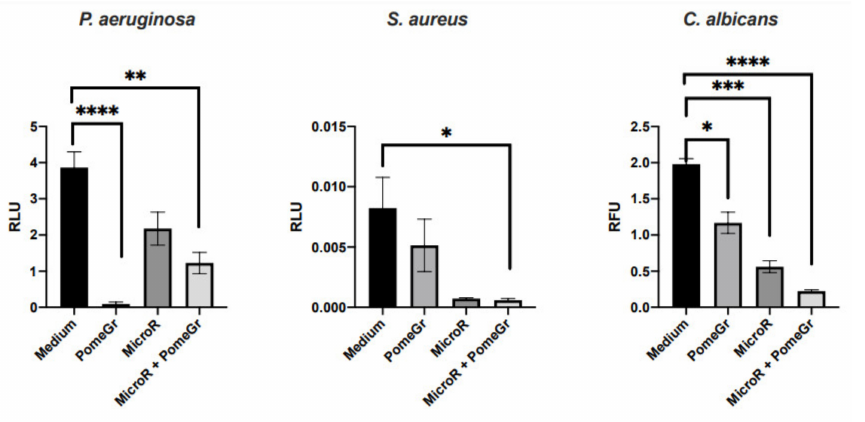
Figure 1. Antibiofilm efficacy of MicroR and/or PomeGr against P. aeruginosa , S. aureus and C. albicans . The microorganisms (10 6 /mL) were exposed to MicroR (4.7 mg/mL) or PomeGr (5.6%) or both and incubated at 37 ◦ C for 24 h; then, biofilm was quantified by luminescence or fluorescence analysis, as detailed elsewhere. The data are the mean ± standard deviation of 6 to 9 determinations from 3 to 4 experiments. Statistical analysis was performed by using GraphPad Prism 8 software. The asterisks indicate statistically significant differences of medium vs . treated samples (* p = 0.05, ** p < 0.01, *** p < 0.001 and **** p <